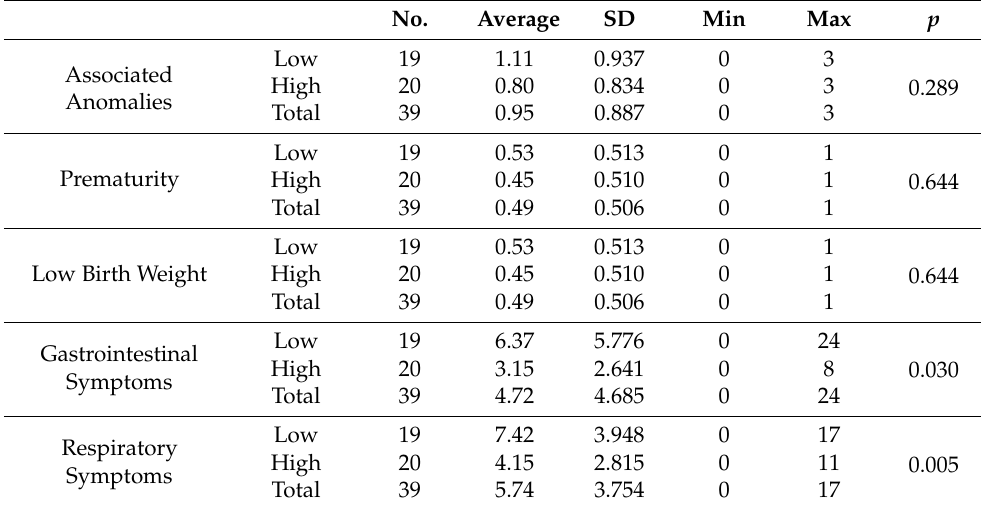
Table 7. Score of quality of life in relation to clinical